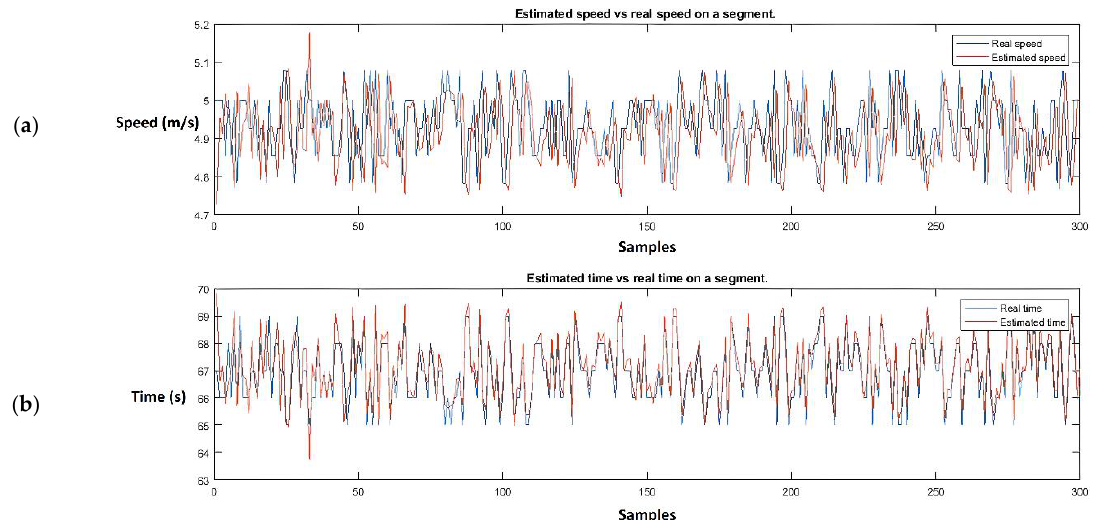
Figure 11. Linear prediction considering 300 trips and 50 previous samples: ( a ) estimated speed vs. real speed on a segment; ( b ) estimated time vs real time on a segment.